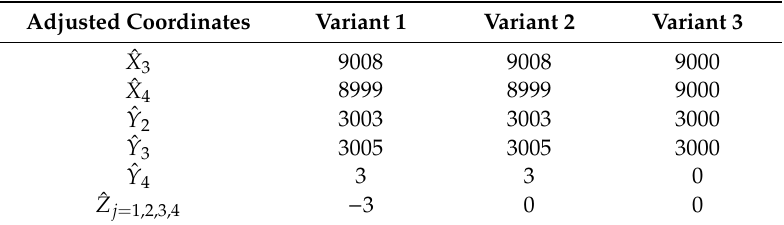
Table 6. Adjusted coordinates of controlled points of the crane bridge (in